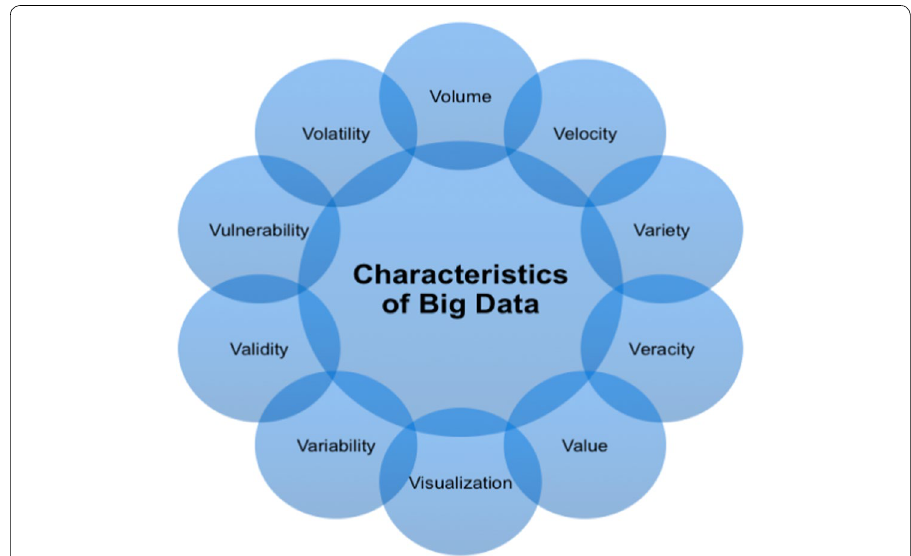
Fig. 3 Characteristics of big